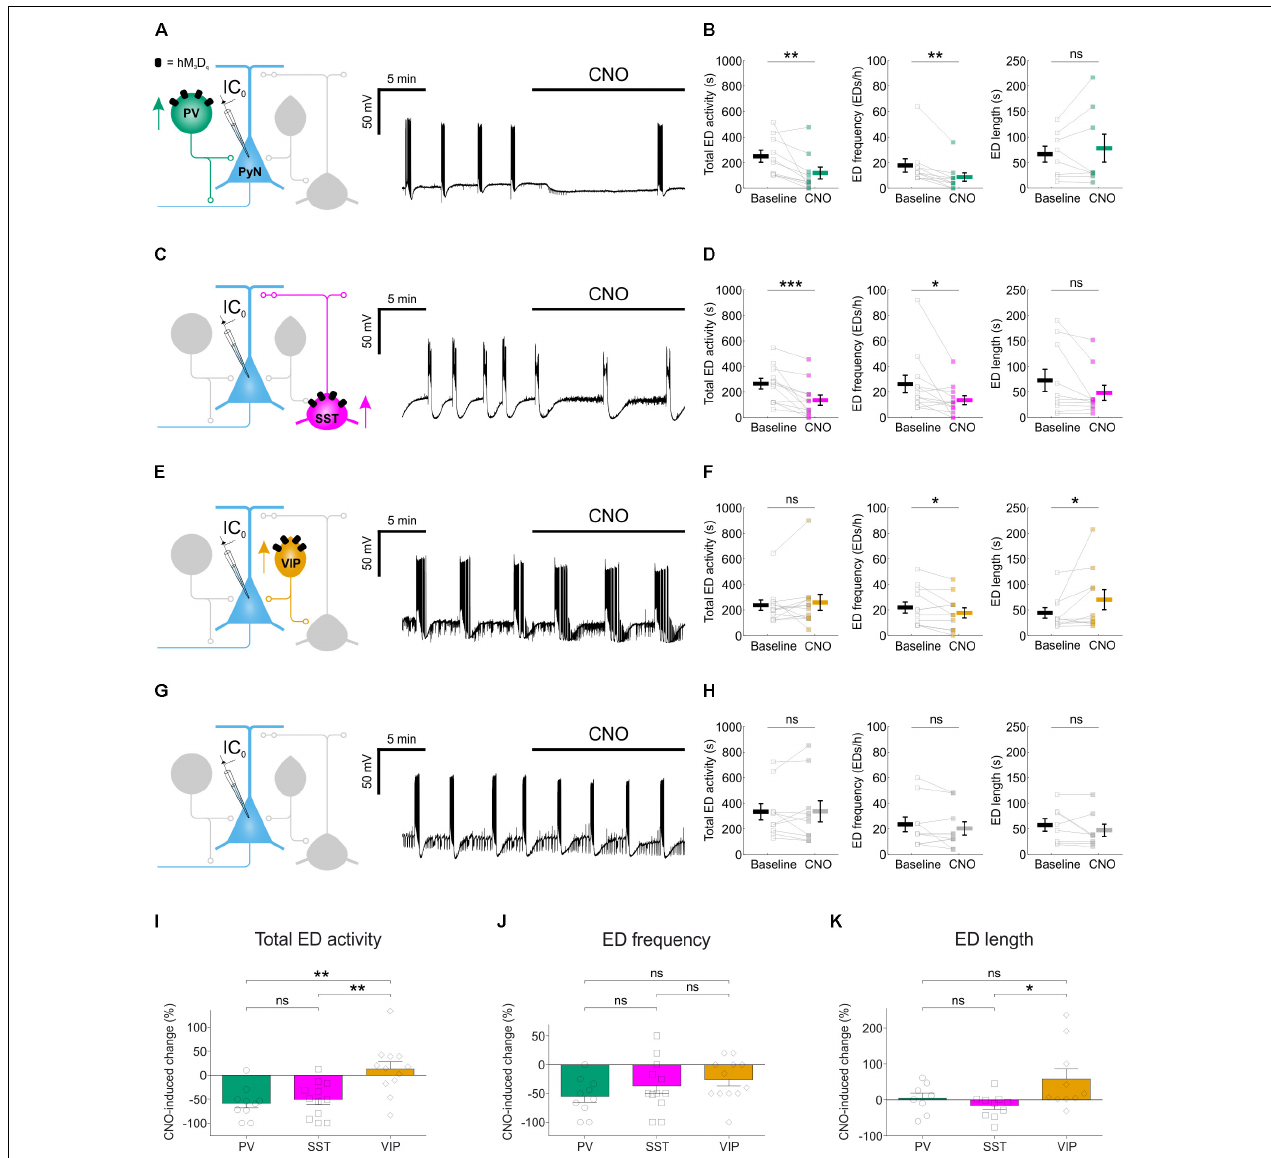
FIGURE 4 | Chemogenetic enhancement of specific GABAergic interneuron populations attenuates hippocampal EDs. (A) PV-cre mice and floxed viral constructs were used to target hM 3 D q receptors to PV interneurons in organotypic hippocampal brain slices. The effects of CNO upon spontaneous EDs were monitored by current-clamp recordings from CA1 or CA3 pyramidal neurons. (B) Population data from experiments targeting PV interneurons ( N = 10 slices) showed a reduction in total ED activity [left, W ( 10 ) = 1, p = 0.0039, two-tailed Wilcoxon signed-rank test], a decrease in ED frequency [middle, W ( 9 ) = 0, p = 0.0039, two-tailed Wilcoxon signed-rank test], and no change in ED length [right, W ( 8 ) = 12, p = 0.4609, two-tailed Wilcoxon signed-rank test] following addition of CNO. (C) SST-cre mice were used to target hM 3 D q receptors to SST interneurons. (D) Population data from experiments targeting SST interneurons ( N = 12 slices) showed a reduction in total ED activity [left, W ( 12 ) = 1, p = 0.001, two-tailed Wilcoxon signed-rank test], a decrease in ED frequency [middle, W ( 12 ) = 6, p = 0.0166, two-tailed Wilcoxon signed-rank test], and no change in ED length [right, W ( 10 ) = 10, p = 0.0840, two-tailed Wilcoxon signed-rank test] following addition of CNO. (E) VIP-cre mice were used to target hM 3 D q receptors to VIP interneurons. (F) Population data from experiments targeting VIP interneurons ( N = 12 slices) showed no change in total ED activity [left, W ( 12 ) = 25, p = 0.3013, two-tailed Wilcoxon signed-rank test], a reduction in ED frequency [middle, t ( 11 ) = 2.24, p = 0.0468, two-tailed paired t -test], and an increase in ED length [right, W ( 10 ) = 6, p = 0.0273, two-tailed Wilcoxon signed-rank test] following addition of CNO. (G) Control experiments were conducted on slices that had not received floxed DREADD constructs. (H) Population data ( N = 10 slices) demonstrated no change in total ED activity [left, t ( 9 ) = –0.08, p = 0.9337, two-tailed paired t -test], ED frequency [middle, t ( 9 ) = 1.31, p = 0.2229, two-tailed paired t -test], or ED length [right, W ( 8 ) = 6, p = 0.1094, two-tailed Wilcoxon signed-rank test] following the addition of CNO to control slices. (I) Total ED activity was significantly reduced by chemogenetically enhancing either PV or SST interneurons, compared to enhancing VIP interneurons [ F ( 2 , 31 ) = 9.747, p = 0.0005, one-way ANOVA, followed by Tukey’s post hoc multiple comparison tests; VIP vs. PV, p = 0.0013; VIP vs. SST, p = 0.0025]. (J) The frequency of EDs was reduced when PV interneurons, SST interneurons or VIP interneurons were targeted. No significant difference in the reduction of ED frequency was detected across the three interneurons [ F ( 2 , 31 ) = 1.583, p = 0.2215, one-way ANOVA]. (K) Individual EDs became significantly longer when VIP interneurons were recruited, compared to SST interneurons [ F ( 2 , 25 ) = 3.772, p = 0.037, one-way ANOVA, followed by Tukey’s post hoc multiple comparison tests; VIP vs. SST, p = 0.0337]. ∗ p < 0.05, ∗∗ p <